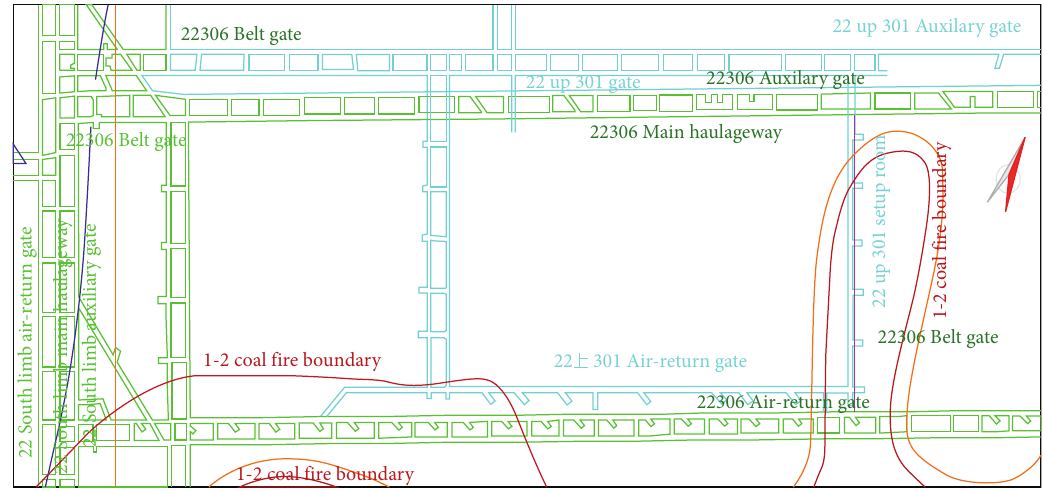
Figure 2: Relative locations of the 22306 mining face and the upper cover 22-upper-301 goaf in the Shigetai mine.